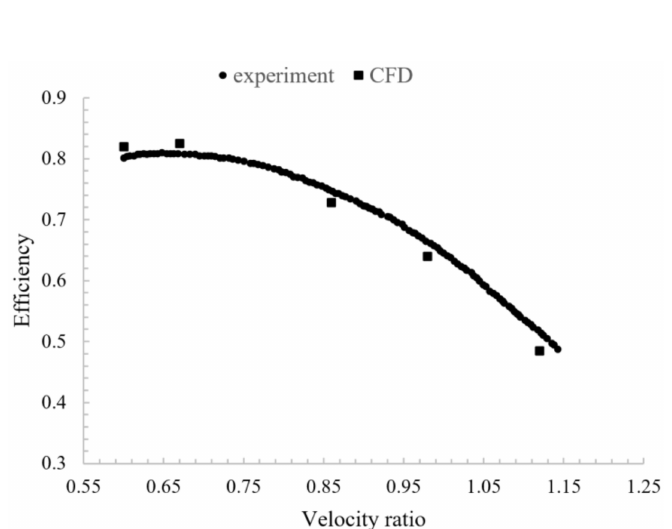
Figure 3. Comparison of computed and measured efficiency against velocity